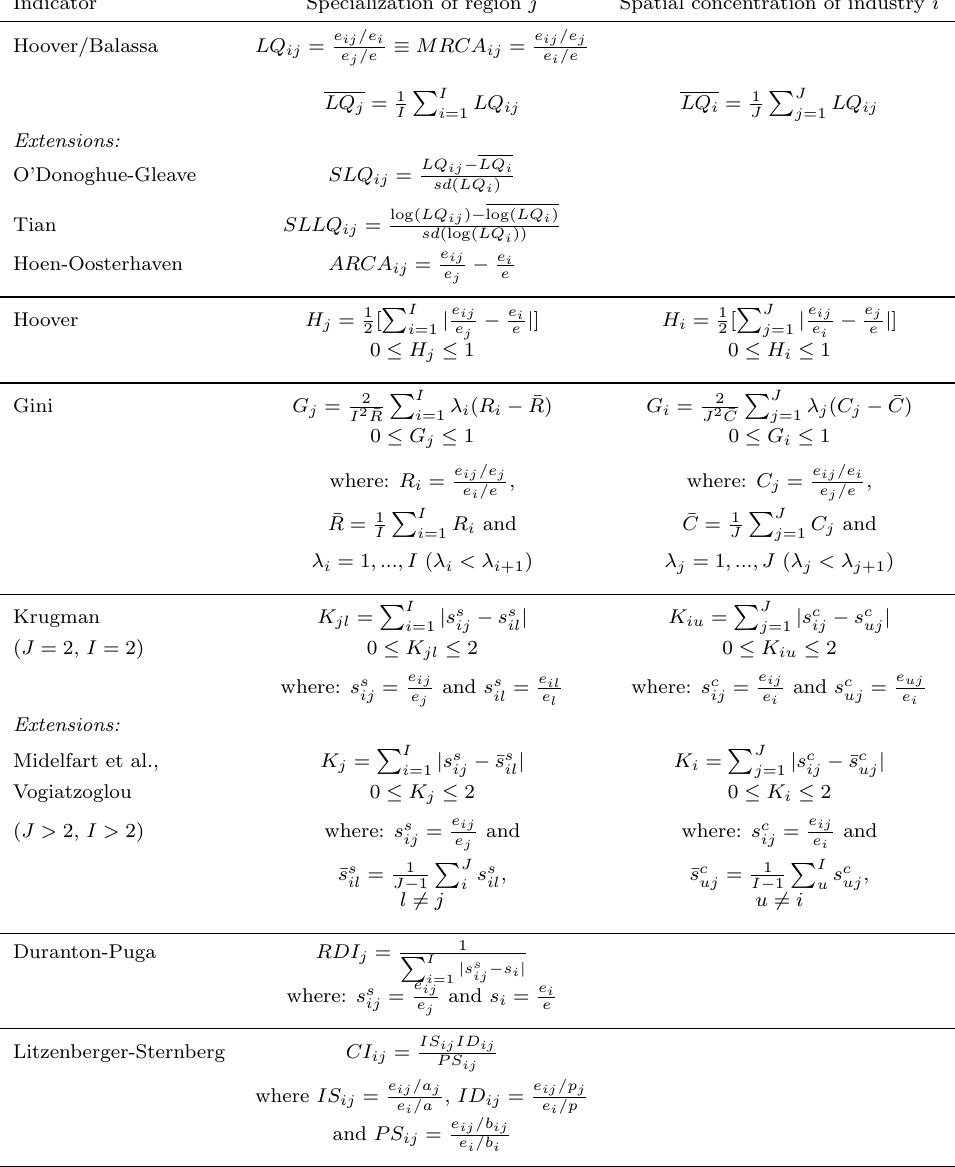
Table 5: Coefficients of regional specialization and industry concentration Indicator Specialization of region j Spatial concentration of industry i